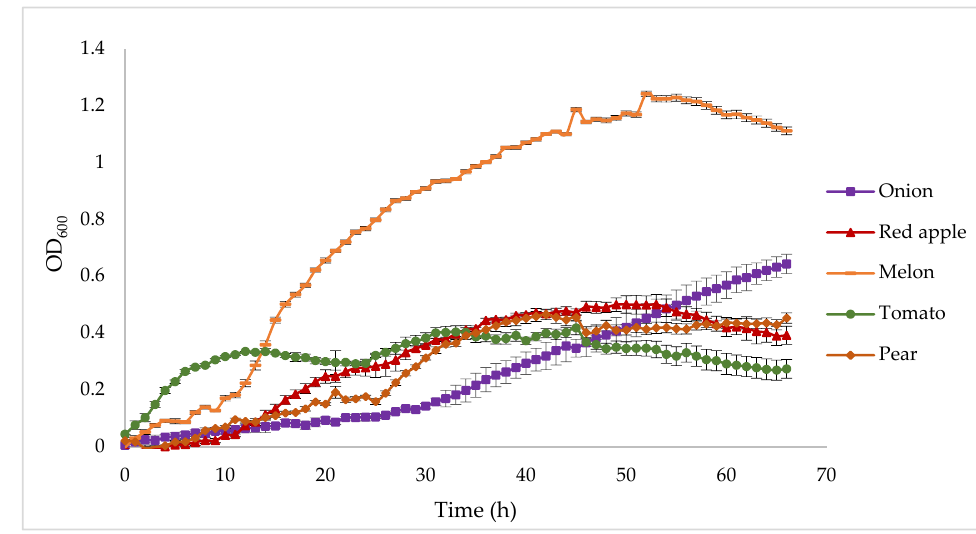
Figure 1. Growth (OD 600 ) of C. necator DSM 545 at 30 °C in DMSZ-81 broth supplemented with water-extracted solutions of different fruit and vegetable waste. The data are the means of three replicates (±SD).